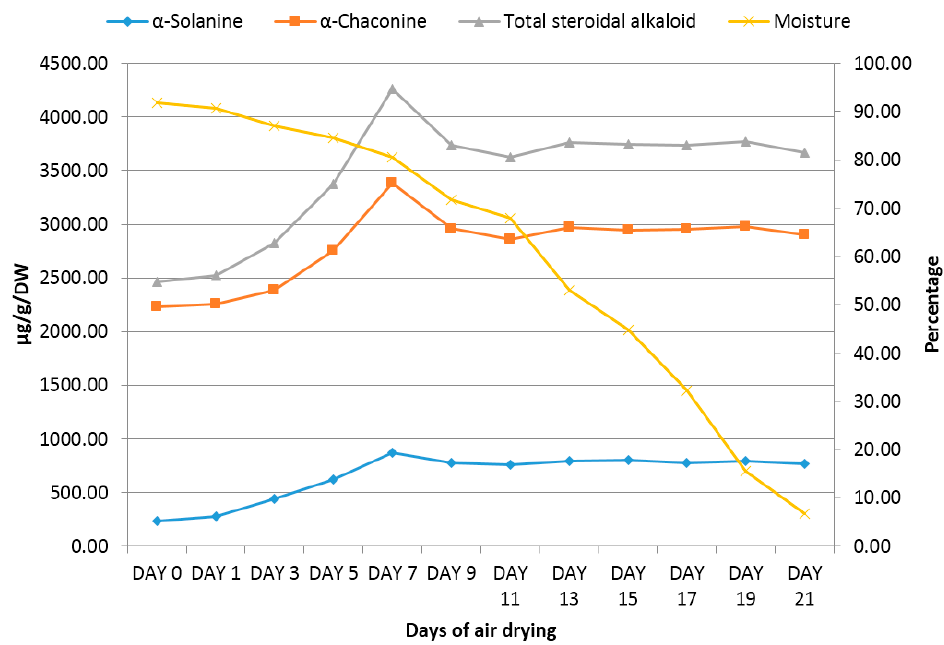
Figure 3. Kinetics of steroidal alkaloids during air drying of potato shoots ( n = 6). Table 1. Moisture loss (%) of the samples during drying (Mean ± SD, n = 6).